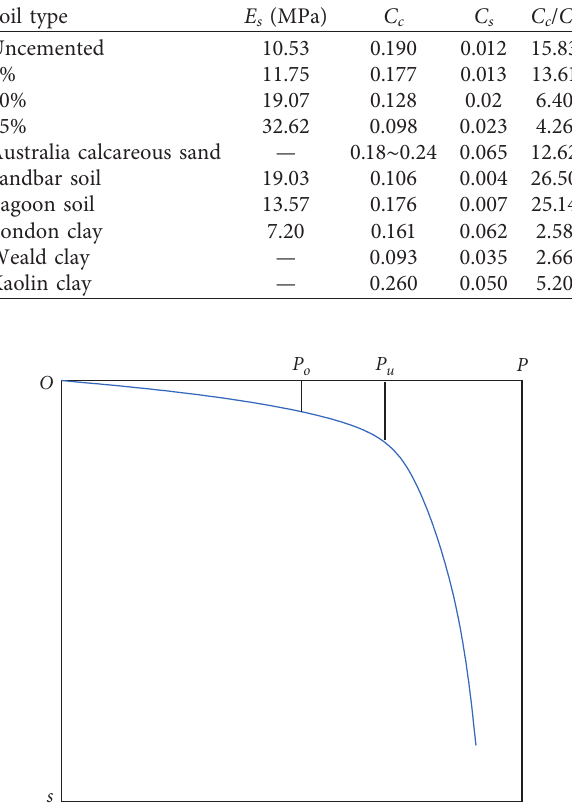
Figure 9: A typical curve of PLT